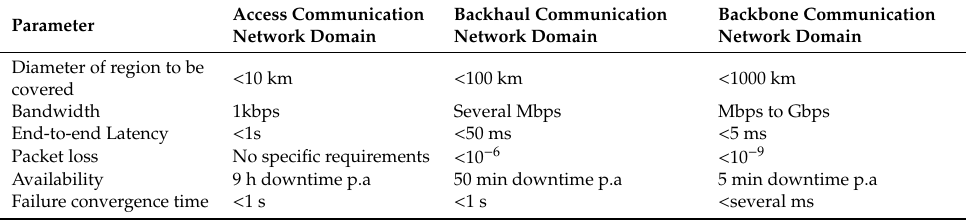
Table 3. Overview of the requirements for network domains in smart grid infrastructure.